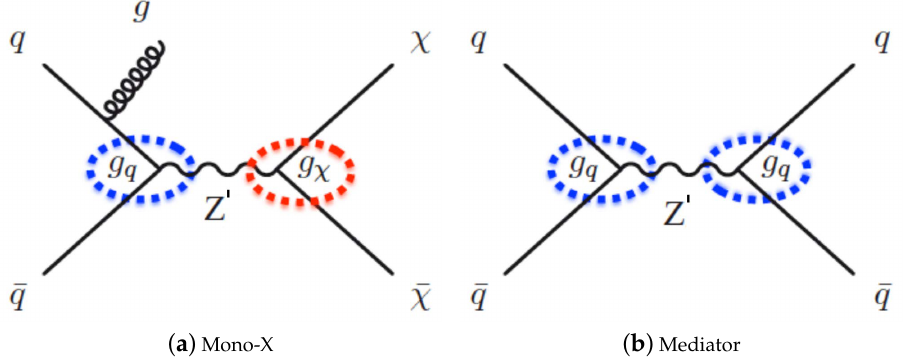
Figure 1. Schematic representation of the two search techniques presented in this